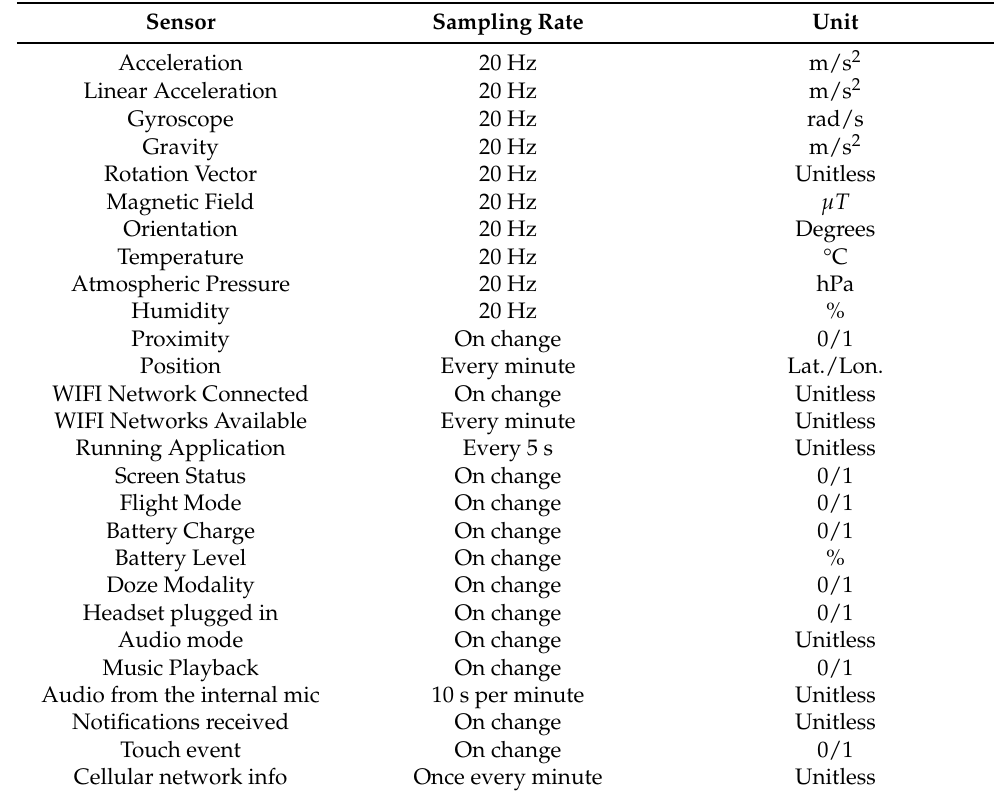
Table 2. List of